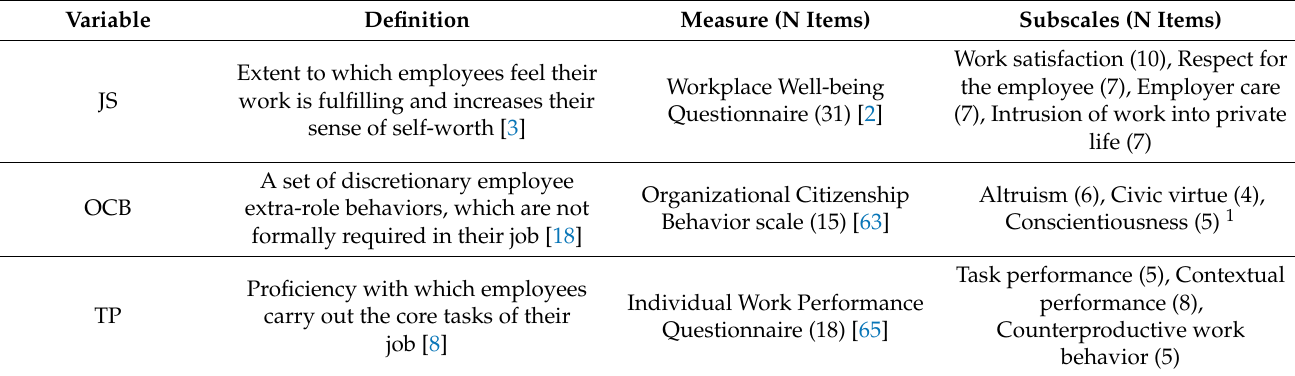
Table 2. Definitions and measures of study